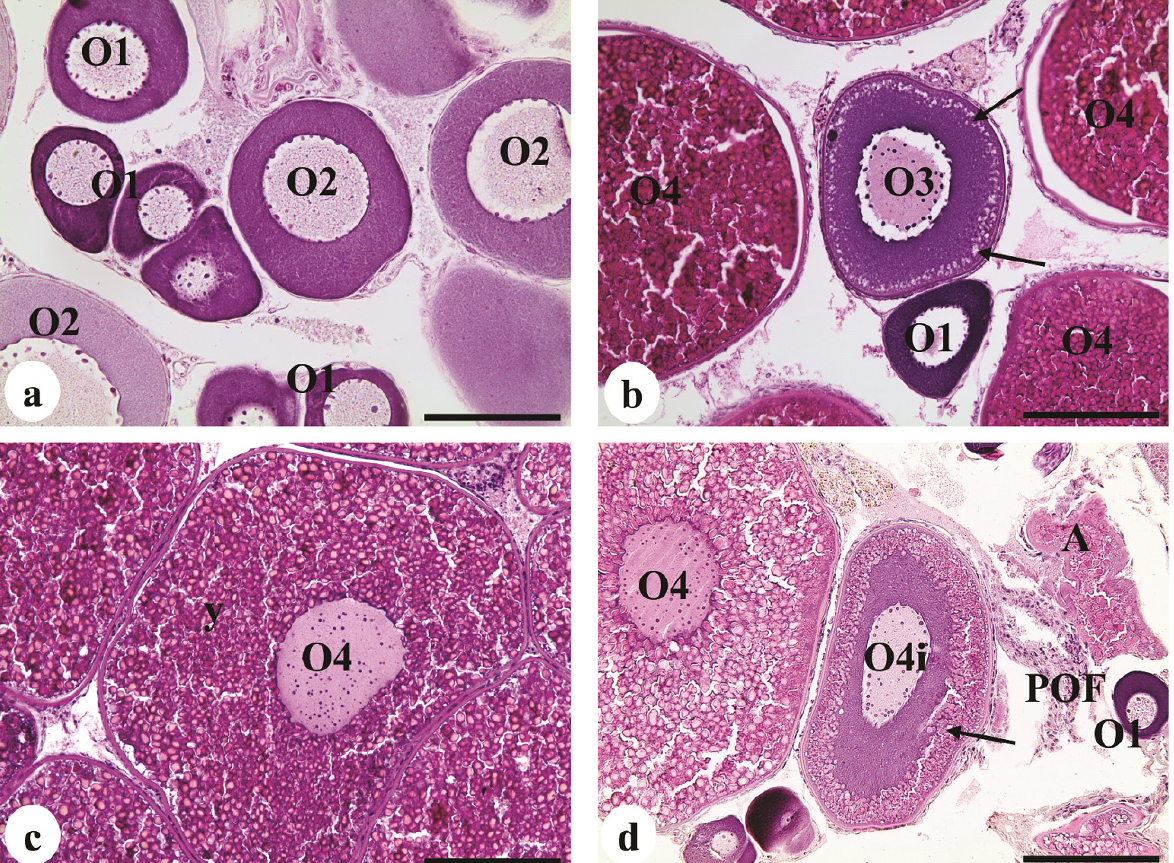
Figure 2. Histological sections of S. elegans ovaries in the different stages of the gonadal maturation are stained by HE. a) Stage F1 = rest with initial perinucleolar follicles (O1, diameter = 80.70 ± 12.43 µm). It’s with basophilic cytoplasm and vesiculous nucleus and advanced perinucleolar follicles (O2 = 149.66 ± 21.10 µm), as well as granular cytoplasm and nucleus with nucleoli attached to the nuclear envelope; b) Stage F2 = maturation with previtellogenic oocyte (O3 = 217.10 ± 36.05 µm), presenting characteristic cortical alveoli (arrow) and vitellogenic follicles (O4 = 442.01 ± 51.72 µm) with ooplasm full of yolk globules; c) Detail of O4 showing squamous follicular cells (FC), thin zona radiata (ZR) and spherical and acidophilus yolk globules (Y); d) Stage F3 = spawned with post- ovulatory follicles (POF) and follicles at all stages of development as well as atretic follicles (A) and previtellogenic follicles (O4i) with early of acidophilus yolk globules (arrow). Bars: a and b = 100 μm; c and d = 200